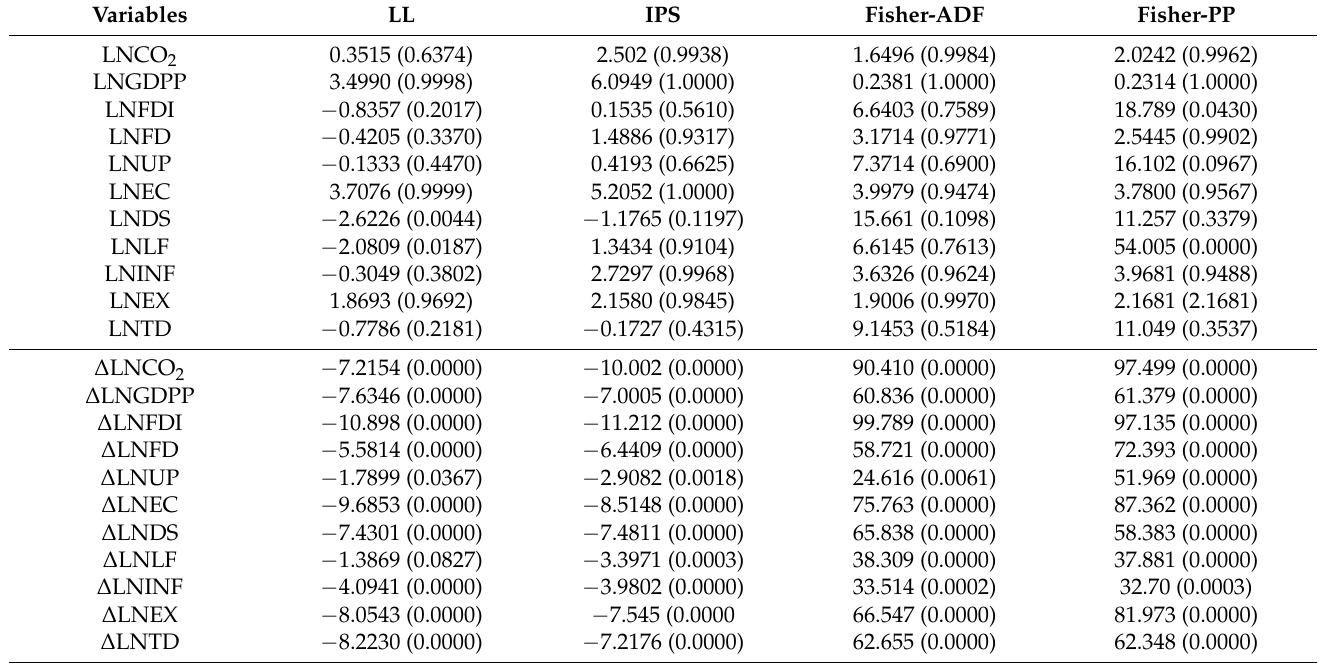
Table 3. Results of Unit Root Tests